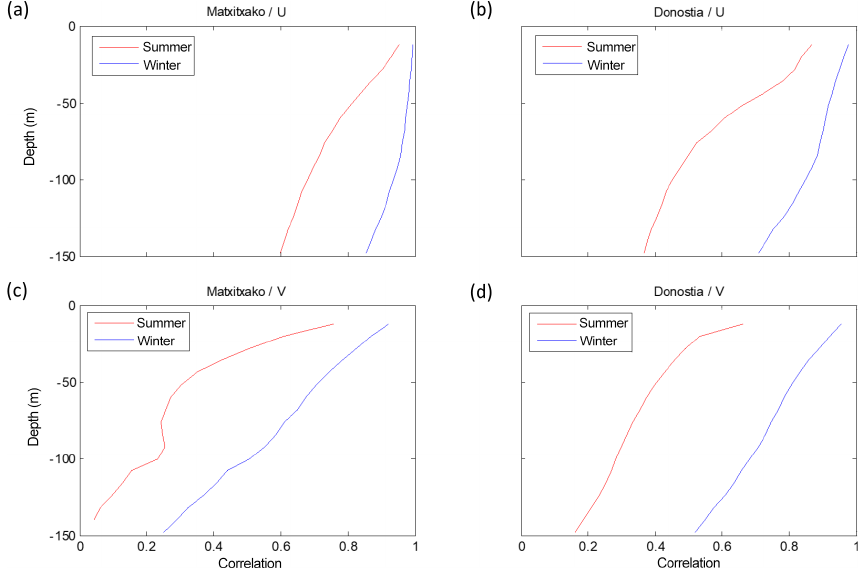
Figure 3. U (a, b) and V (c, d) temporal cross-correlations between the surface and the water column levels for winter (blue) and summer (red) periods. In the Matxitxako location (a, c) and in the Donostia location (b, d) .